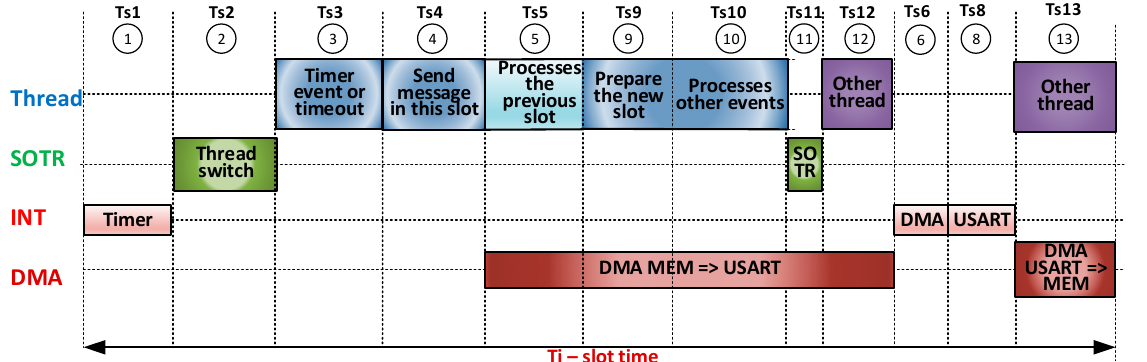
Figure 7. Pipeline SW (thread, RTOS, and ISR)/HW (DMA)—Scenario 2.